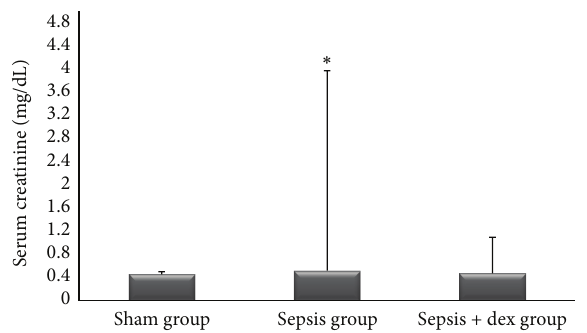
Figure 4: Kidney tissue mononuclear cell infiltration scores in experimental groups. ∗ 𝑃 < 0.05 compared with sham and sepsis + dex groups.